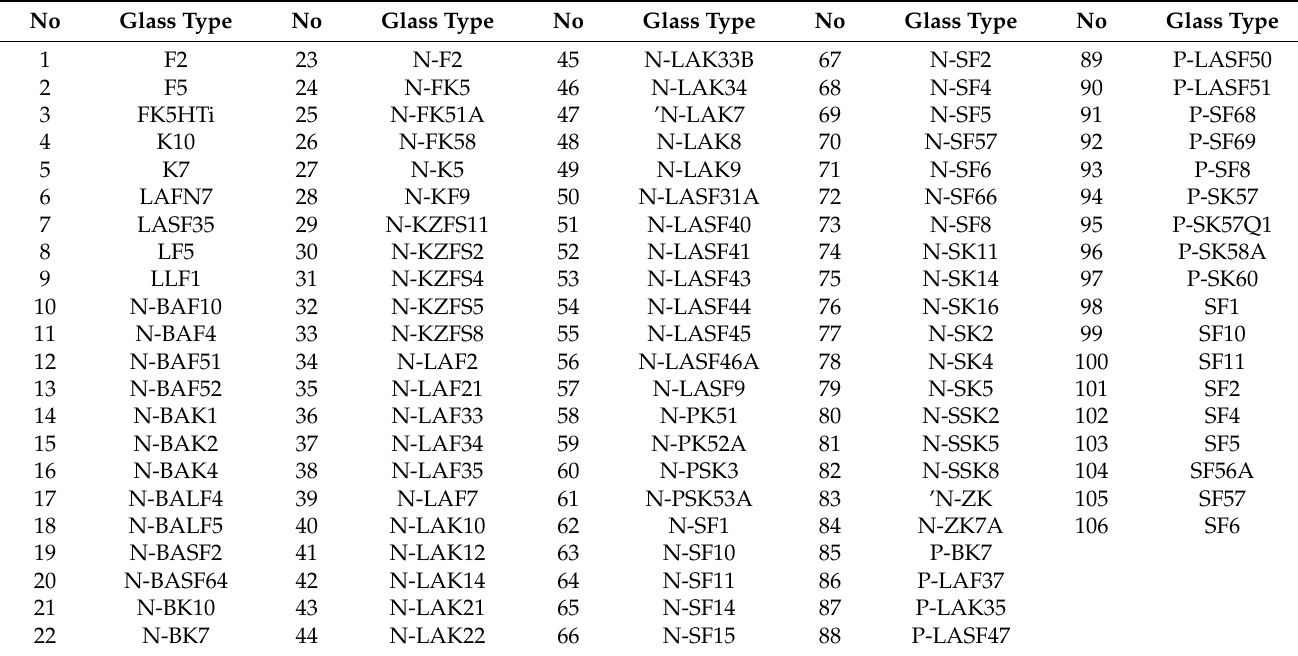
Table 1. Schott glass type and